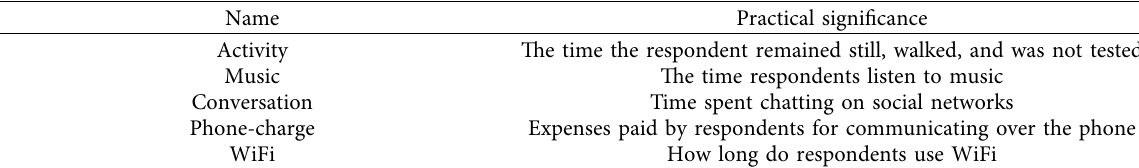
Figure 3: Feature screening Table 4: Practical significance of important features.